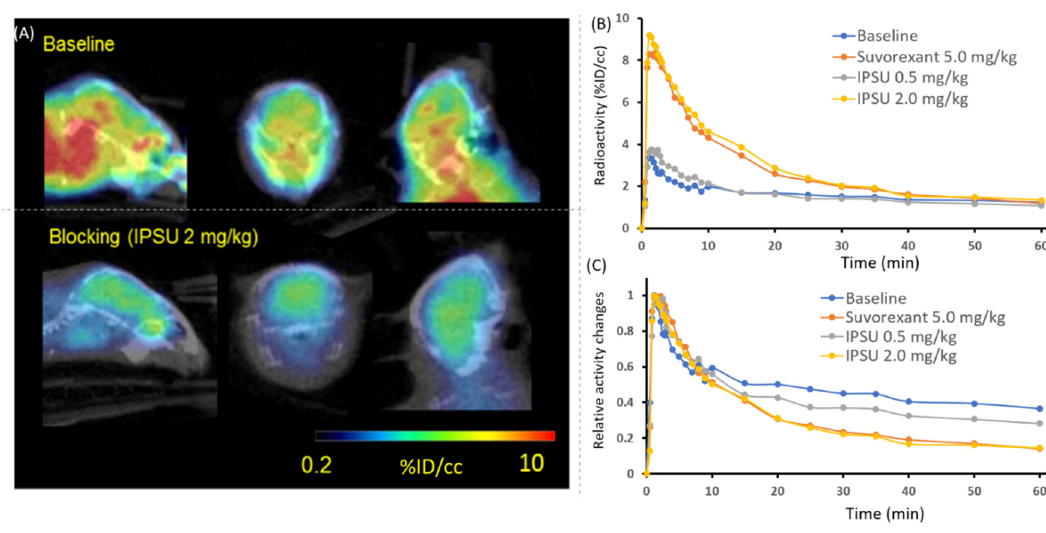
Figure 3. ( A ) The PET / CT imaging of [ 11 C]CW24 focused on mice brain (20-60 min after intravenous administration (i.v.)); ( B ) baseline and blocking time-activity curve (TAC) of [ 11 C]CW24 and ( C ) TAC after normalized the brain uptake curves with the highest uptake time point (20 seconds post- injection).